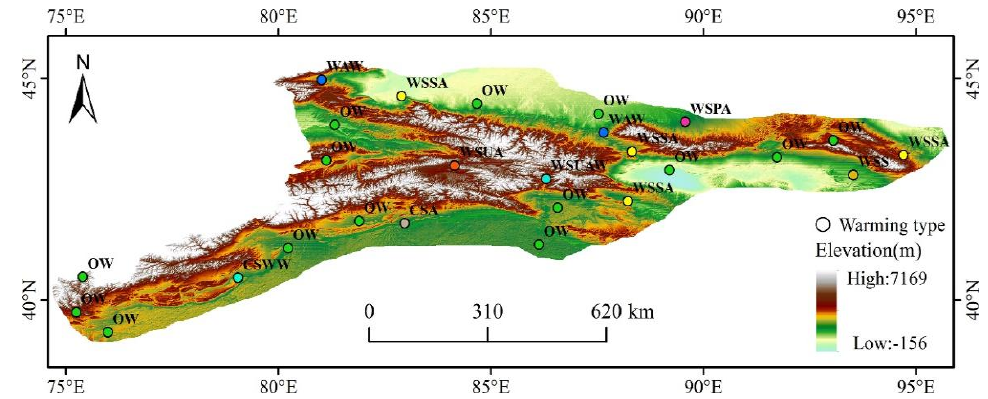
Figure 4. The spatial distribution of warming types in the CTMR . OW: overall warming; WSSA: warming in spring, summer, and autumn; WAW: warming in autumn and winter; WSUAW: warming in summer, autumn, and winter; WSS: warming in spring and summer; WSUA: warming in summer and autumn, WSPA: warming in spring and autumn; CSUA: cooling in summer and autumn; CSUWW: cooling in summer and warming in winter.